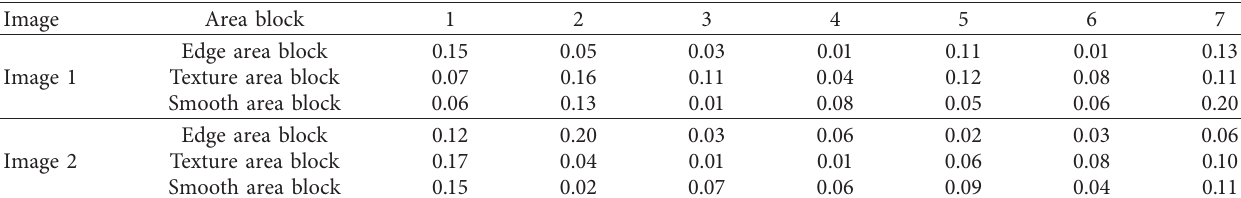
Table 2: Priorities of different blocks to be